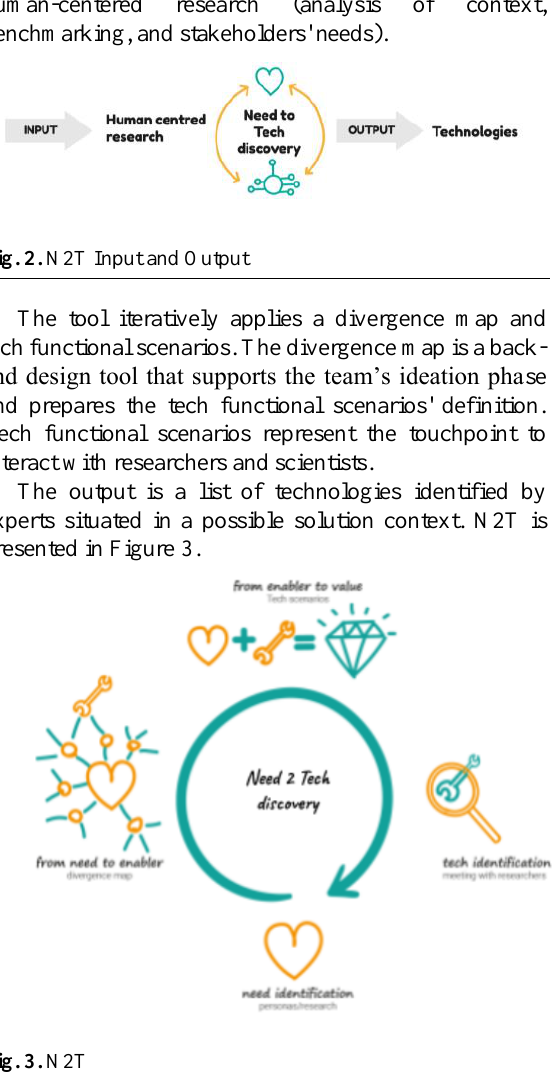
Fig. 4. An evolutionary divergence map (Encyclopædia Britannica-Url:https://www.britannica.com/science/adaptive-